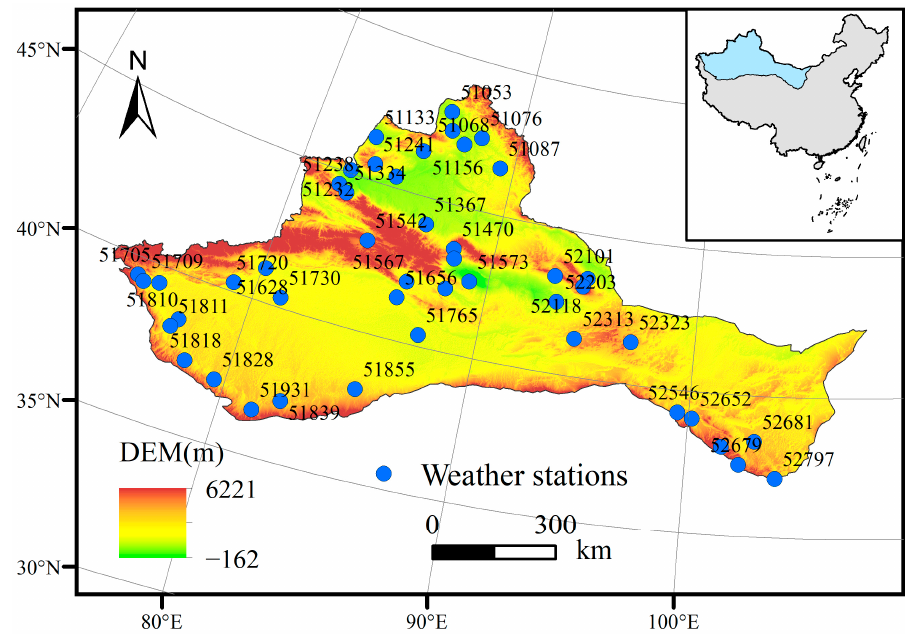
Figure 1. Spatial distribution of weather sites in northwestern China. We used a sample site (no. 52118) located in the central of study area to show in detail the logical process of screening the key circulation indices. DEM is the digital elevation model.